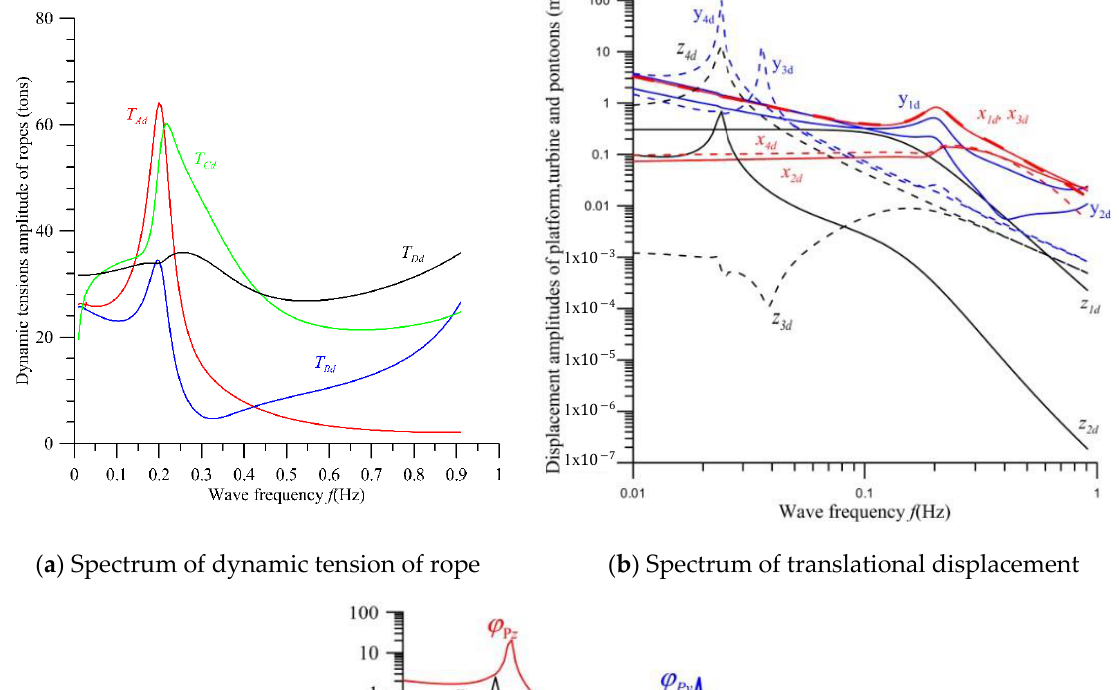
C = 60 m, L D = 140 m, β P